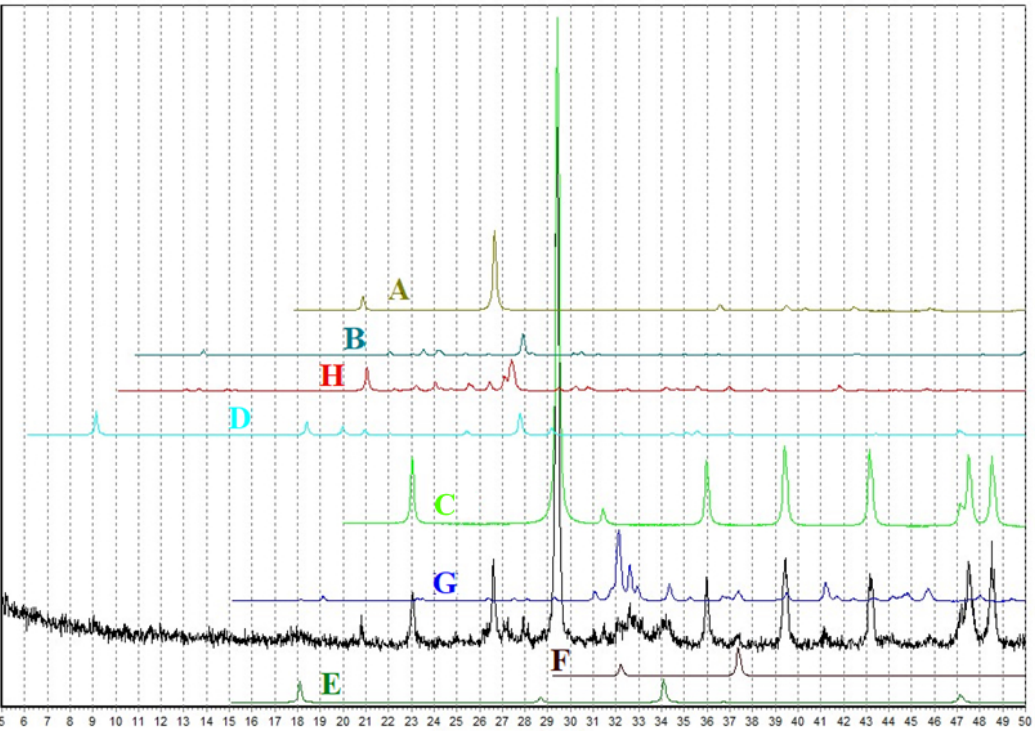
Figure 5. Diffraction pattern of thermally treated (700 °C) marl sample, in comparison with the da- tabase PDF-2. The comparison phases are as follows: A—quartz, B—calcite, C—albite,